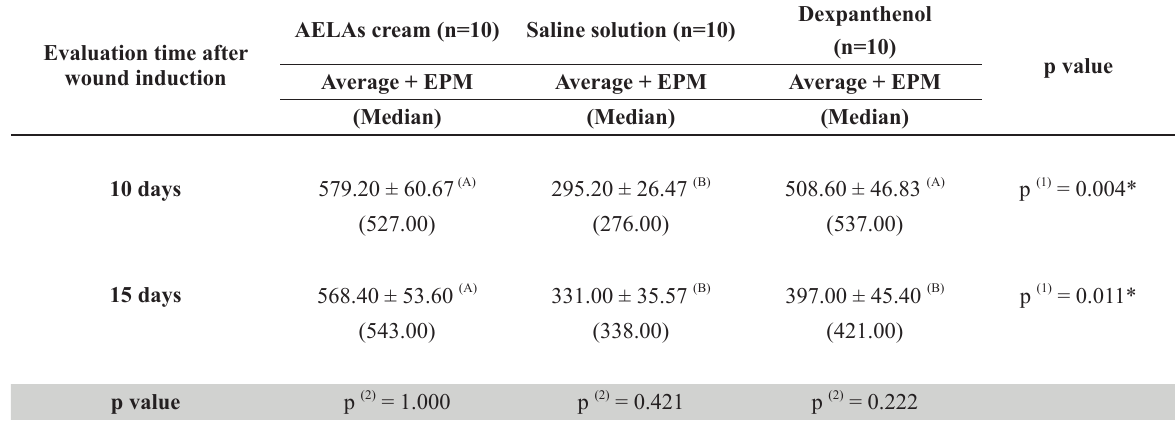
Fibroblast counting after in vivo surgical procedure in 10 and 15 days. Evaluation time after wound